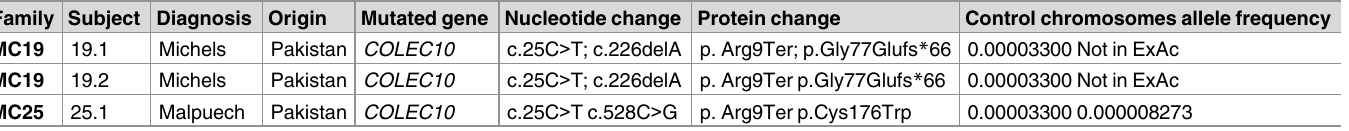
Table 2. New COLEC10 mutations found in families MC19 and